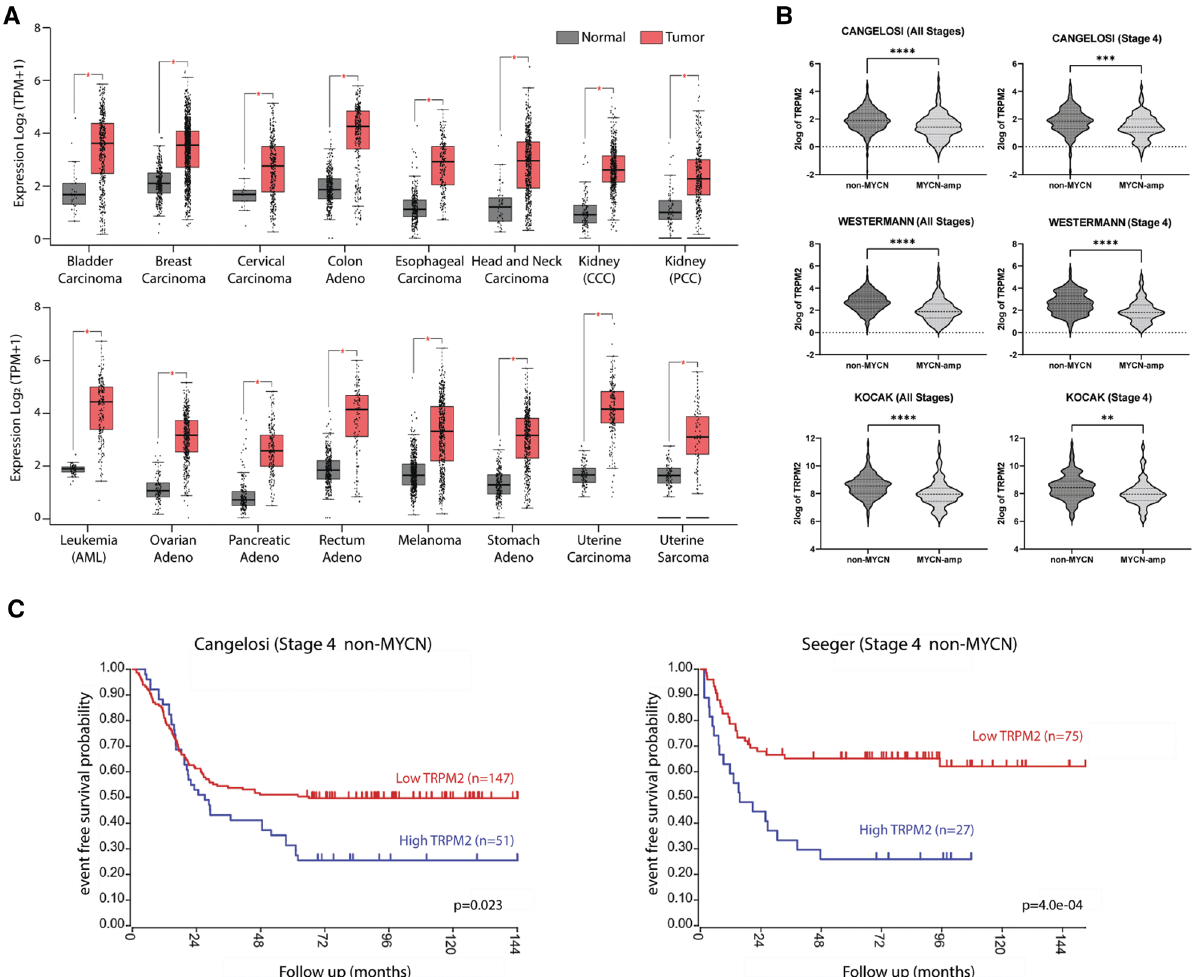
Figure 1. TRPM2 is highly expressed in many cancers. ( A ) TRPM2 expression is increased in many malignancies compared to normal tissue. The GEPIA2 tool was used to analyze and compare TCGA tumor datasets to TCGA and GTEx normal datasets (See "Materials and Methods"). The number of samples for each tumor type are shown in Supplementary Table 1. The median 25–75 percentiles are boxed and the 10–90 percentiles for each group shown with lines. The median is shown with a bar. Significant differences were assessed with one-way ANOVA. * p < 0.01. ( B ) Expression of TRPM2 was analyzed in neuroblastoma samples from all stages of disease and in Stage 4 using three databases in the R2 platform (Cangelosi 40 , Westermann, Kocak 41 databases; Supplementary Table 2). Expression levels of TRPM2 were compared between samples with and without MYCN amplification across all stages of disease (left panel) or in Stage 4 (right panel). Data was analyzed by unpaired t-test (** p < 0.01, *** p < 0.001, **** p < 0.0001). ( C ) Kaplan Meier survival plot for Stage 4 neuroblastoma patients without MYCN amplification divided based on level of TRPM2 expression in tumors. Samples in the last quartile for TRPM2 expression were designated High TRPM2 (blue), while remaining samples were grouped into Low TRPM2 (red). Two independent datasets with survival data were used: Cangelosi database 40 (n = 198, p < 0.023); Seeger database 42 (n = 102, p < 0.00029); analyzed with one-way